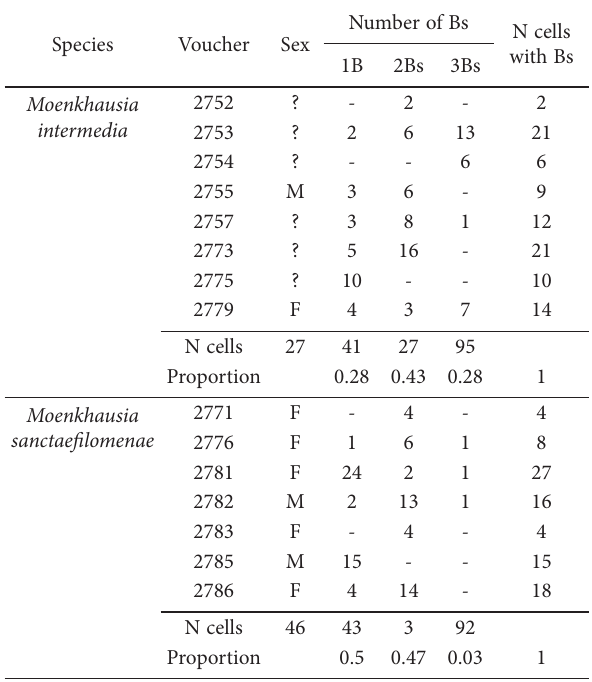
Table 2. B chromosome counts in metaphase cells of Moenkhausia intermedia and M. sanctaefilomenae . F: females, M: males, ?: unde- termined